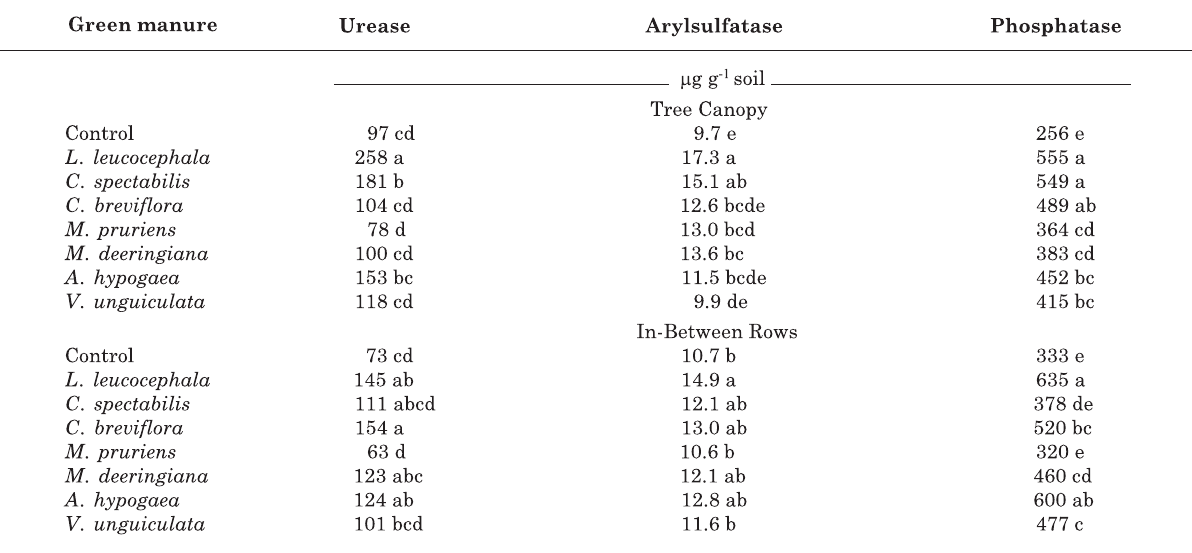
Table 2. Urease, arylsulfatase and acid phosphatase activity under the tree canopy and in-between coffee rows as affected by different legume green